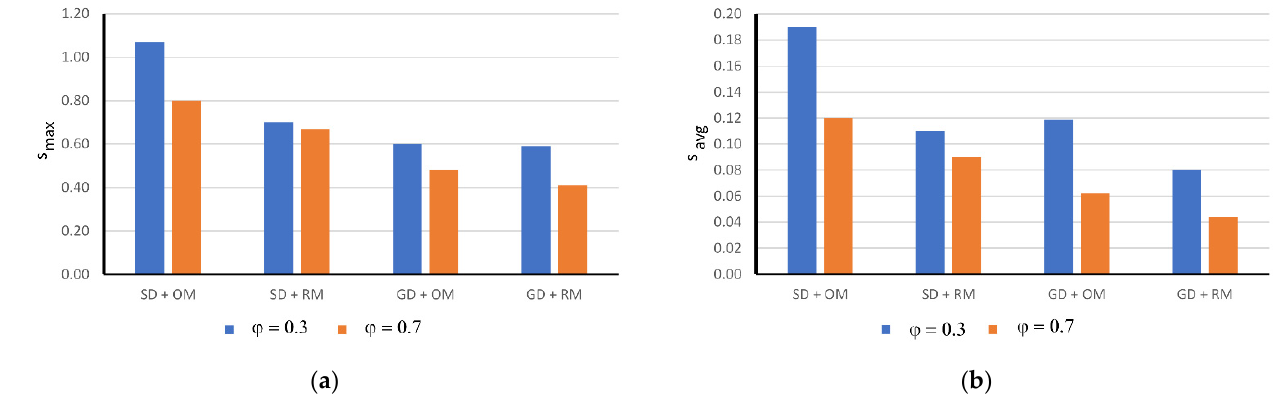
Figure 16. Summary of the maximum values ( a ) and average values ( b ) of road wheel skidding during the simulation when the vehicle model was driven through the ditch at different maximum values of the adhesion coefficient: GD—gear-type flow divider, SD—spool-type flow divider, OM—orbital motor, RM—radial piston motor.